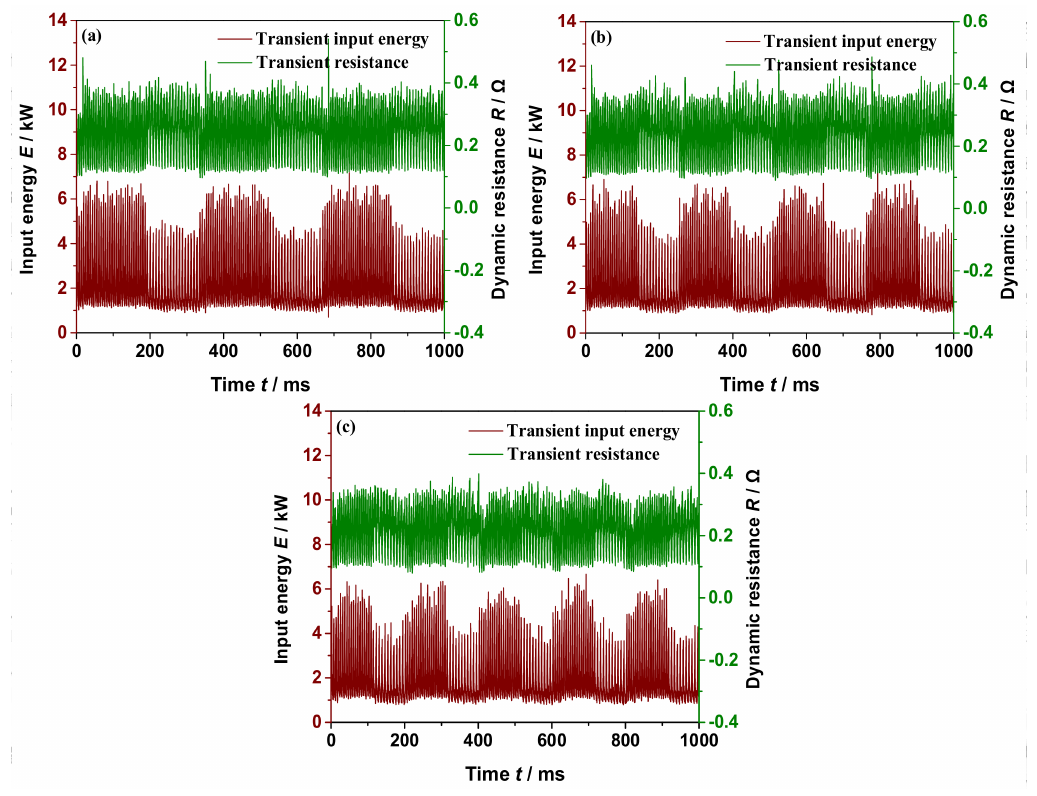
Figure 5. Transient input energy and transient resistance waveforms of DP-GMAW: ( a ) 3 Hz; ( b ) 4 Hz; and, ( c ) 5 Hz.